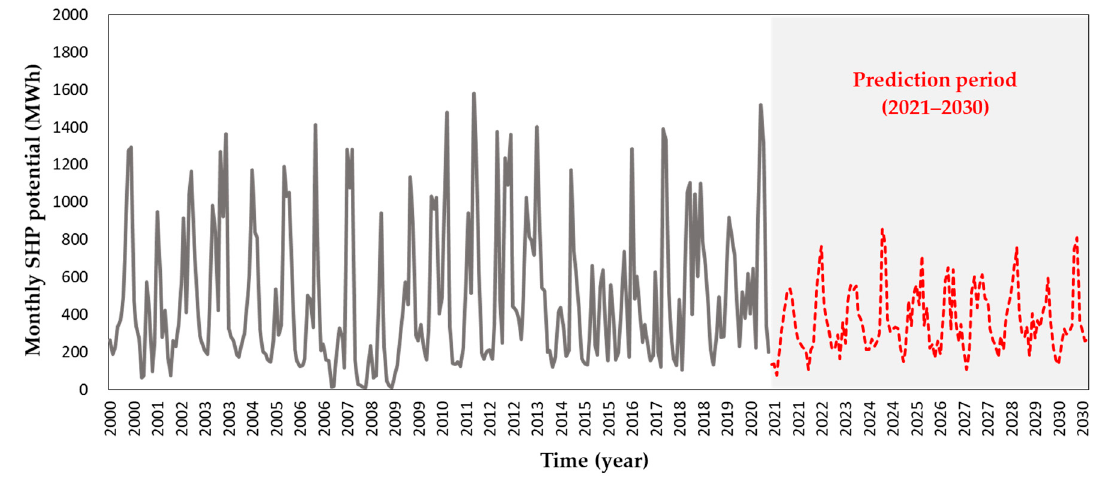
Figure 4. Monthly SHP potential in historic and future periods.